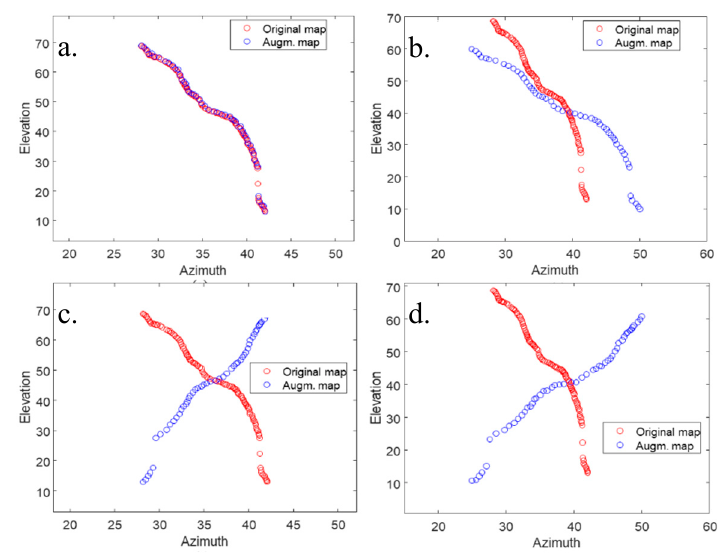
Figure 5. Example of angles augmentation by ( a ) adding Gaussian noise, ( b ) scaling, ( c ) flipping, ( d ) combination of (a, b, and c).